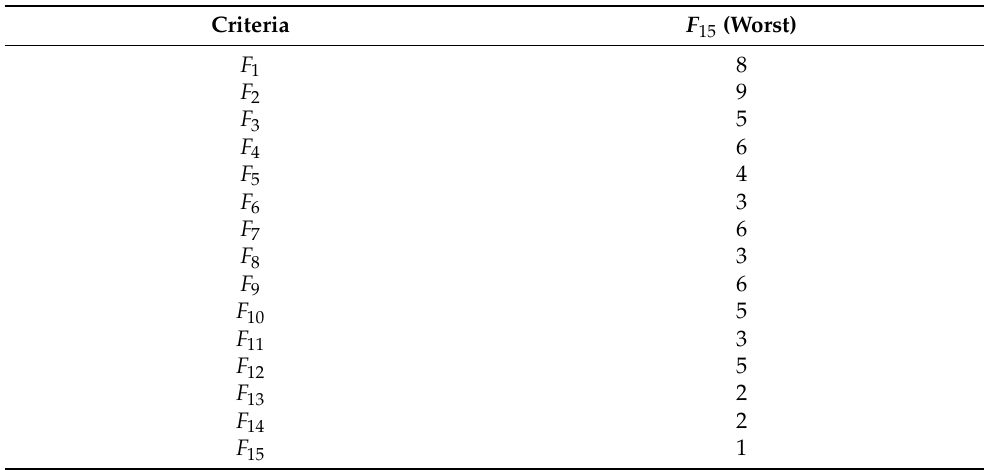
Table 12. The comparison between the other criteria to the